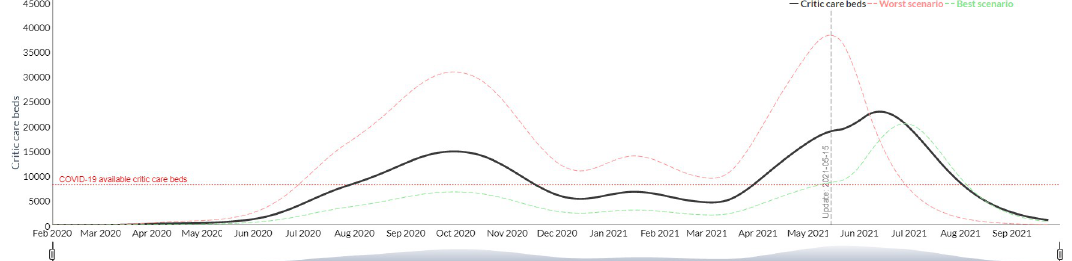
Fig 6. Simulation of the use of intensive care beds for Argentina based on a scenario of constant R_0 without intervention (Argentina).